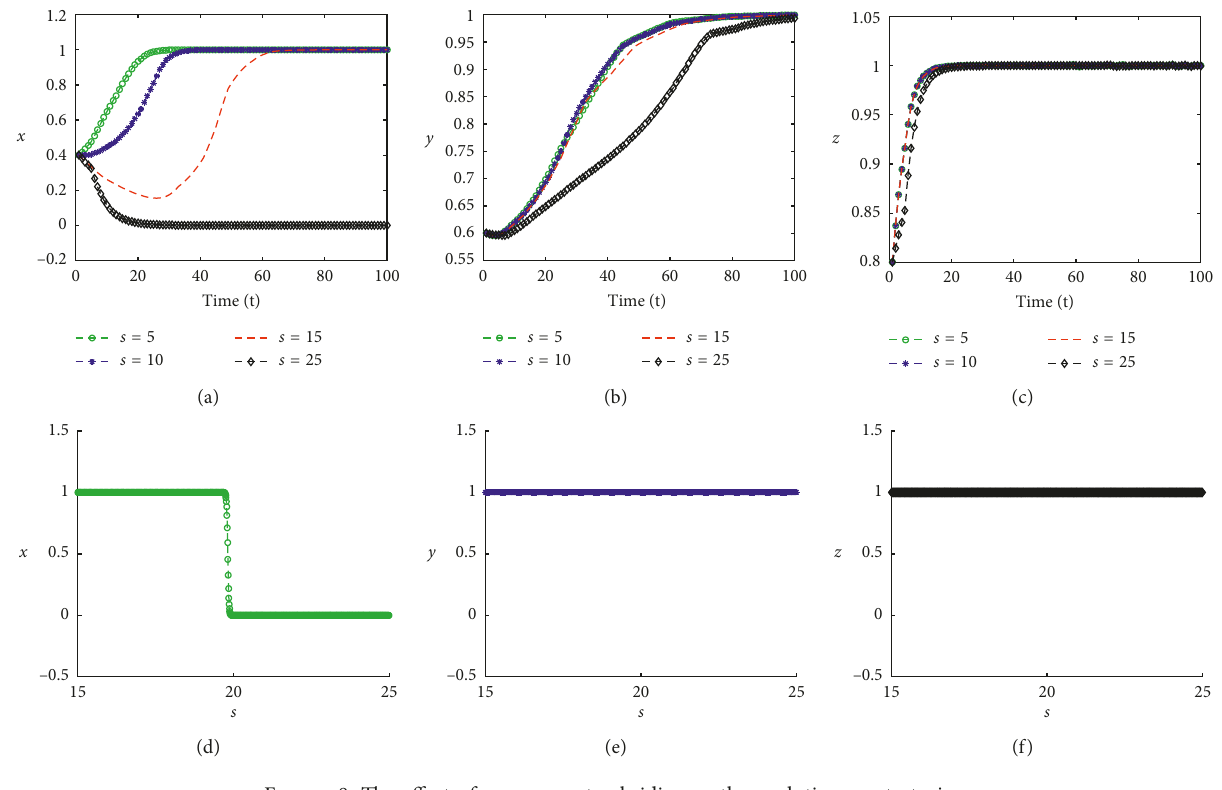
Figure 8: The effect of government subsidies on the evolutionary strategies.